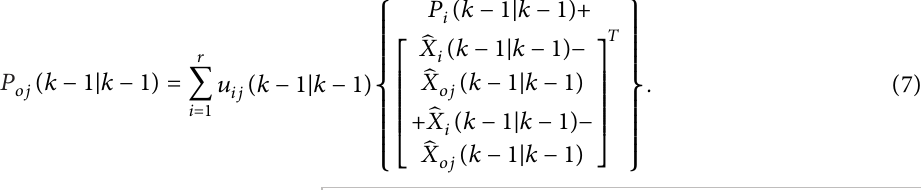
Figure 1: Interactive multimodel workflow